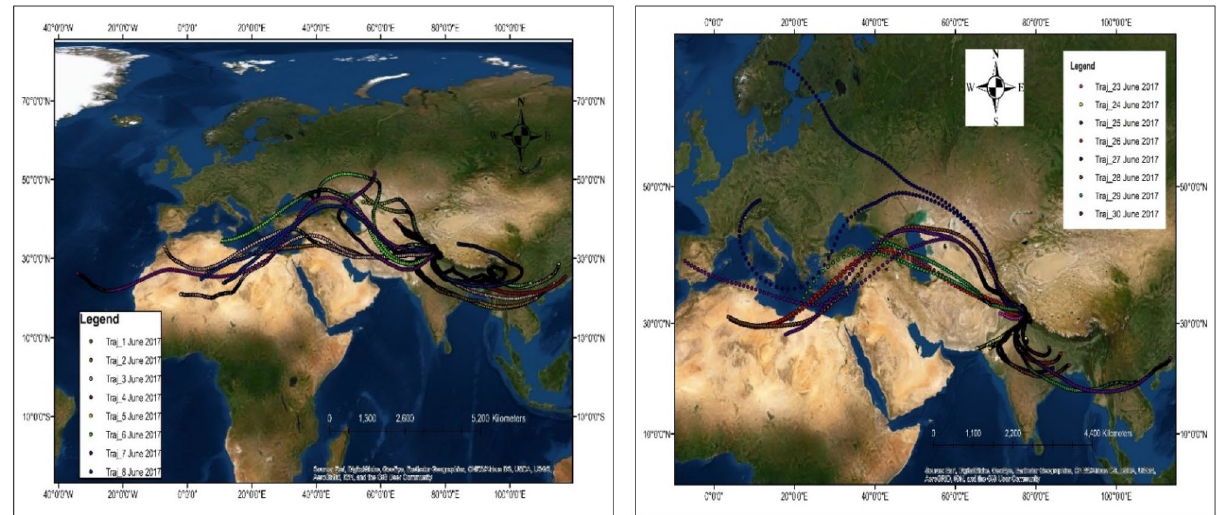
Figure 6. Backward trajectories at rainwater sampling site in Shaune Garang glacier catchment. The NOAA Air Resources Laboratory’s Hybrid Single-Particle Lagrangian Integrated Trajectory (HYSPLIT) model (http:// www. arl. noaa. gov/ ready/ hyspl it4. html) was used to access the origin of air parcels reaching to Shaune Garang catchment at an altitude of 1000–1500 m above the glacier surface. The READY model (Real-time Environmental Applications and Display System) allows users to access and display meteorological data products and run the HYSPLIT transport and dispersion model on the NOAA Air Resources Laboratory’s (ARL) web server.